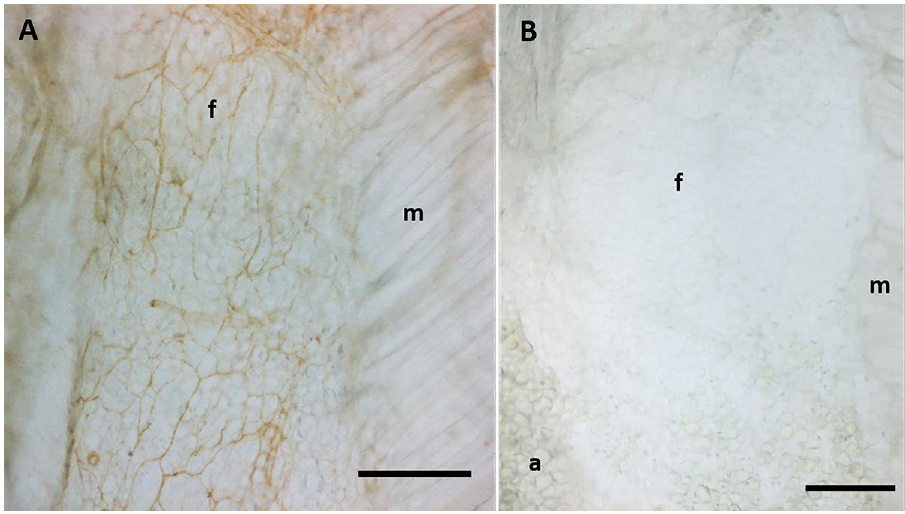
Figure 3. Different density of innervation of fascia and muscle: A : S100 immunohistochemistry reaction of thoracolumbar fascia (f) and latissimus dorsi muscle (m). B : negative control with the omission of the primary antibody. (a): adypocytes; (f): fascia; (m): muscle. Scale bar: 300